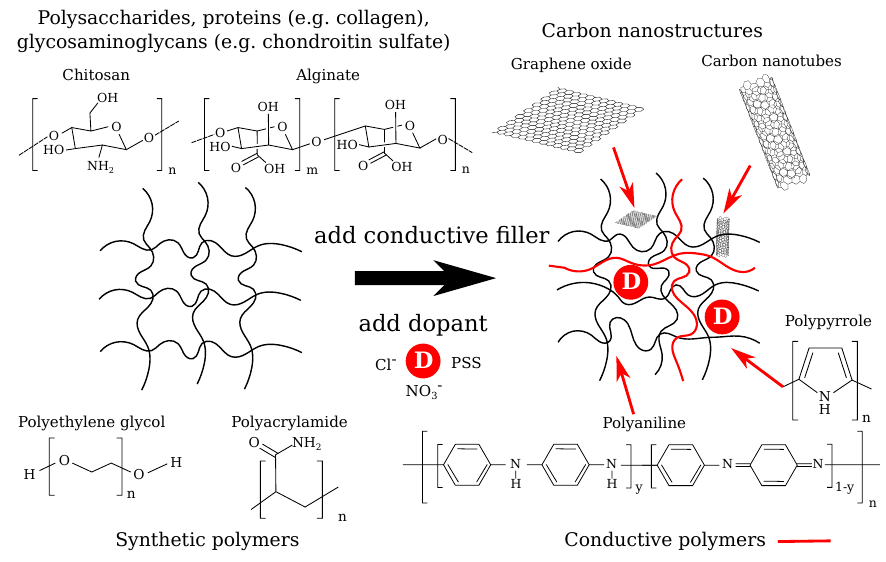
Figure 1. Potential design routes for electrically conductive scaffolds to be used in cartilage tissue engineering. Possible materials for the porous, non-conductive scaffold and for the conductivity tuning using conductive fillers and dopants are shown. The dopant changes the conductivity of the scaffold by adding or removing an electron from/to the polymer, which causes a lattice distortion inducing polarons that yield increased electric conductivity [19]. Carbon nanostructures can be integrated into the scaffold network and provide a pathway for the electric current [20,21]. The final electroactive hydrogel conductivity will be strongly dependent on the degree of percolation between the conductive fillers, purity and crystalinity of the conductive polymer, doping level, redox state of the conductive filler, diffusibility of and ion mobility in the final hydrogel, hydrogel porosity, and additional factors relevant for tuning the final hydrogel